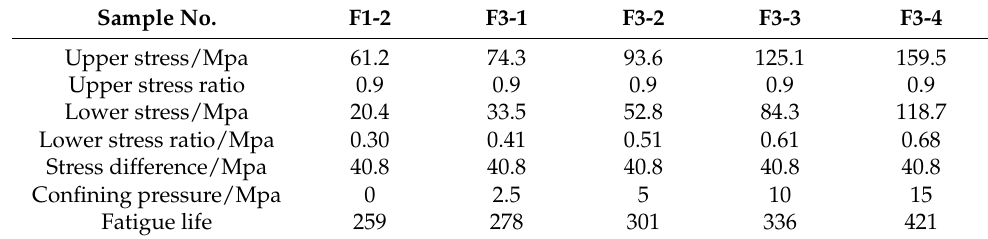
Table 3. The influence of confining pressure on the fatigue life of yellow sandstone samples. Sample